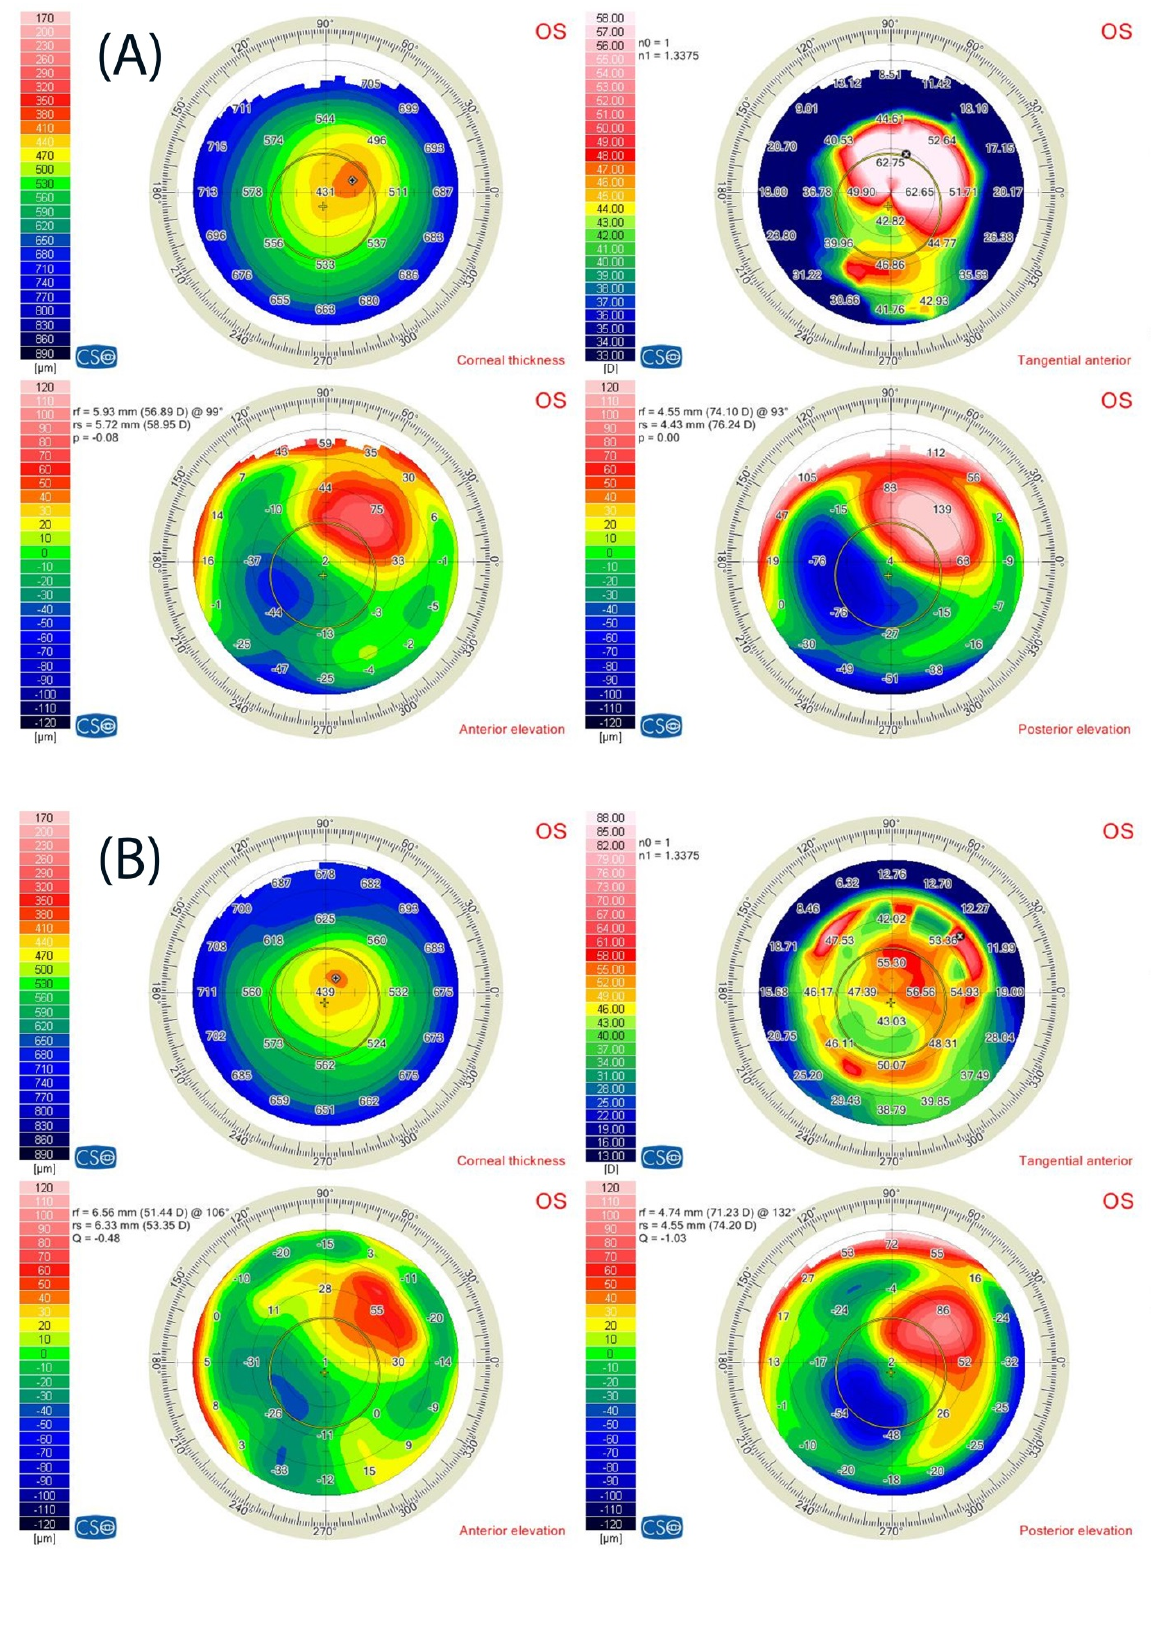
Figure 2: (A) Corneal tomography showed a cone in the superior part of the cornea. (B) Corneal tomography of the same eye after Kerarings implantation showed a marked decrease in the keratometry reading at the superior cone after 12